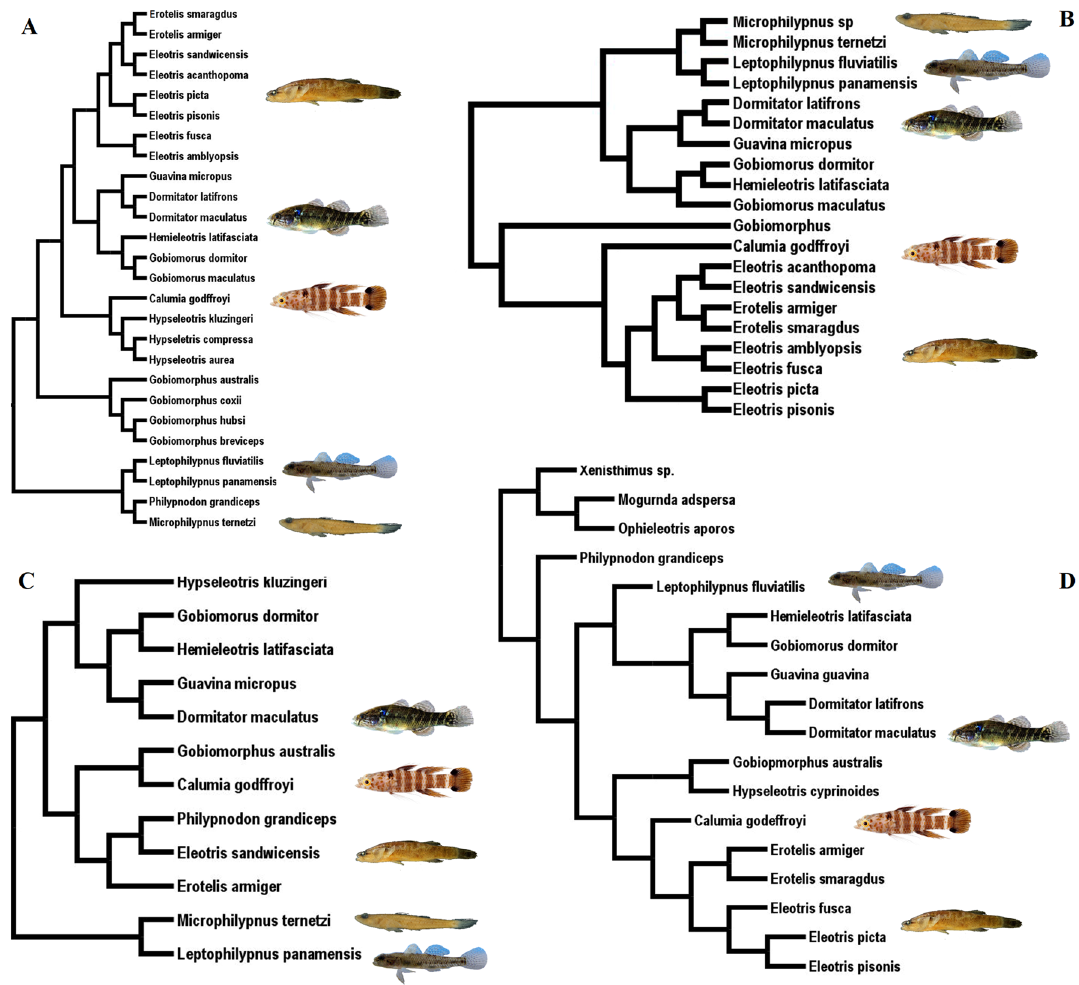
positions of clades Microphilypnus (green), Leptophilypnus (blue), Philypnodon (red) and Calumia